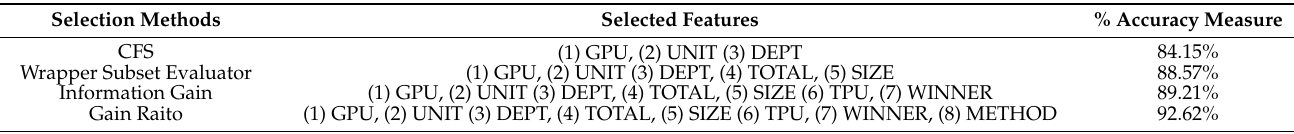
Table 2. Selected features ordered by most relevant for different feature selection methods and corresponding accuracy.